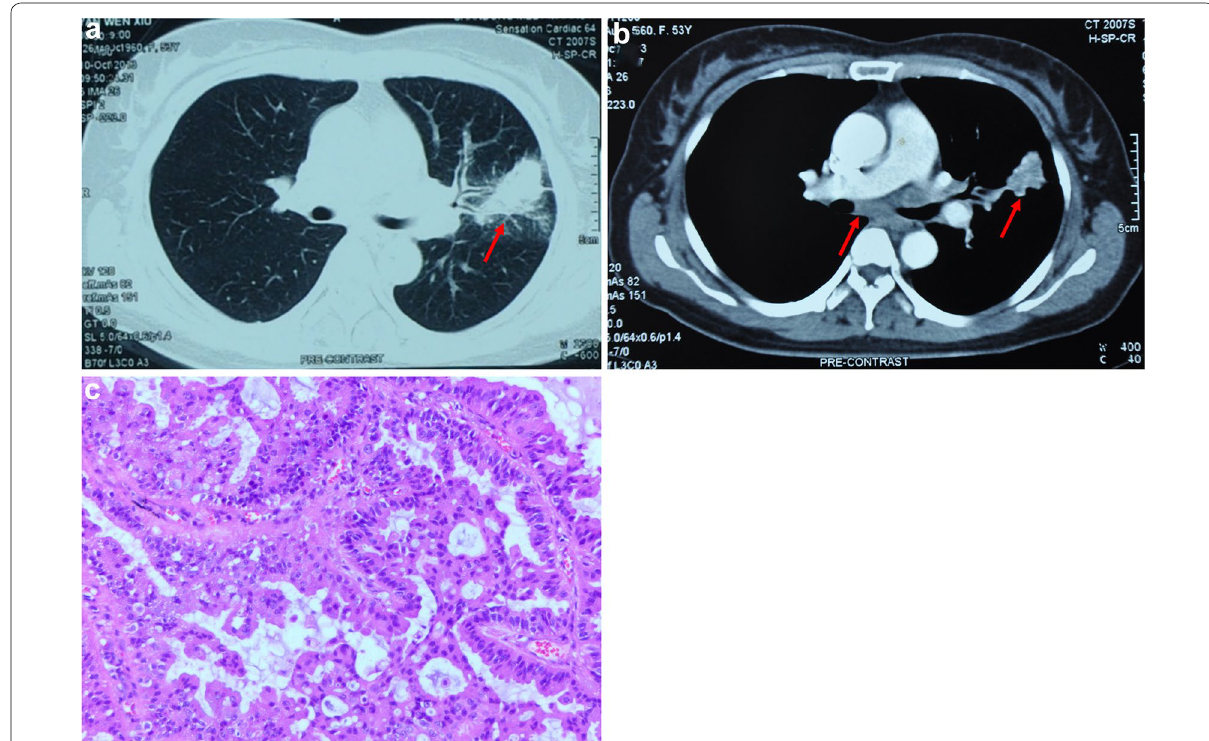
Fig. 1 The Chest CT images and histology of the left lung neoplasm. a Pulmonary window revealed a single pulmonary nodule on the lower left lobe. b Mediastinal window revealed the single pulmonary nodule on the lower left and enlarged subcarinal lymph nodes. c Hematoxylin and eosin staining demonstrated adenocarcinoma (magnification ×